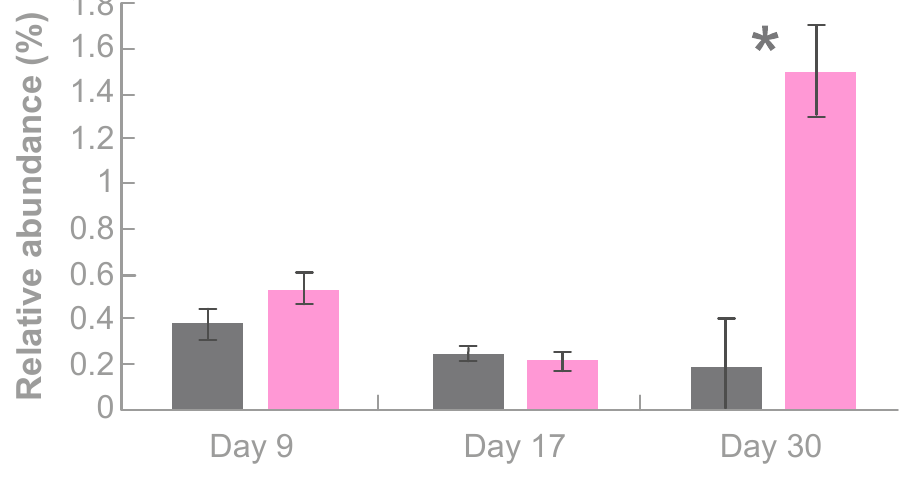
Figure 4. Relative abundance (%) of Streptococcus species in the gut of 9-, 17-, and 30-day-old piglets in the control (grey bars) and supplemented with Tonisity Px (pink bars) groups. Bars represent LSmeans and error bars denote ± SEM. * Indicates statistical significance between treatments at p < 0.05.